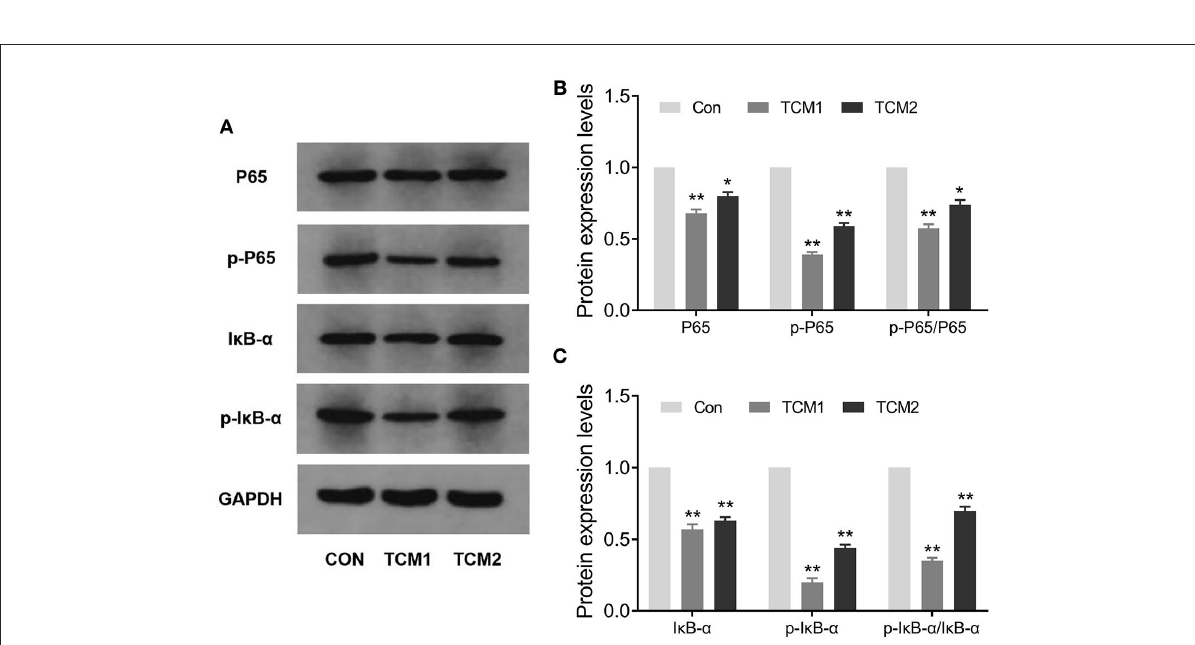
FIGURE5 Effects of TCM supplement on key proteins levels of the NF- κ B signaling pathway. (A,B) Immunoblot analysis of P65 and p-P65 proteins. (C) Immunoblot analysis of I κ B α and p-I κ B α proteins. “*” indicates a significant difference compared with control group (* P < 0.05 and ** P < 0.01).